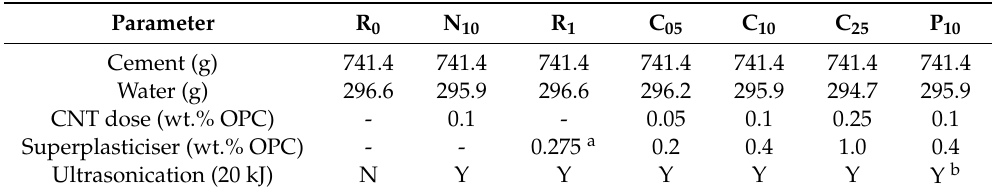
Table 2. Mix proportions for the specimen types investigated. Each mix had a w:b of 0.4. Parameter R 0